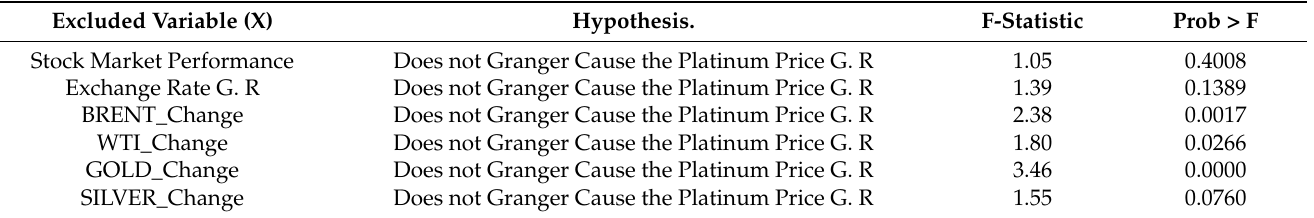
Table A13. Granger Causality test related to the Platinum Price G. R (Regression with Driscoll–Kraay